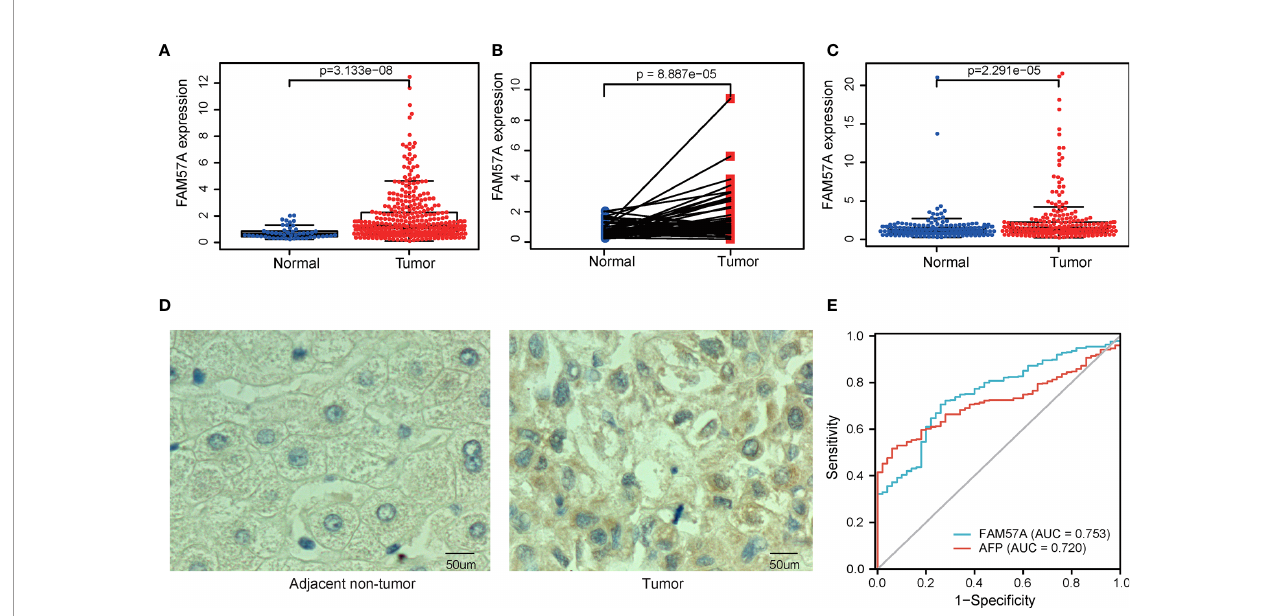
FIGURE 2 | The differentiated expression of FAM57A in samples. (A) FAM57A expression in HCC tissues and nontumor tissue from the TCGA database. (B) FAM57A level in 50 paired cancerous and noncancerous liver samples from the TCGA database. (C) FAM57A level in HCC tissues and nontumor tissue from the ICGC database. (D) Representative immunohistochemical images for paired HCC tissues from our hospital (scale bars=50 m m). (E) AUCs of AFP and FAM57A expression based on the TCGA database. AUC, area under the